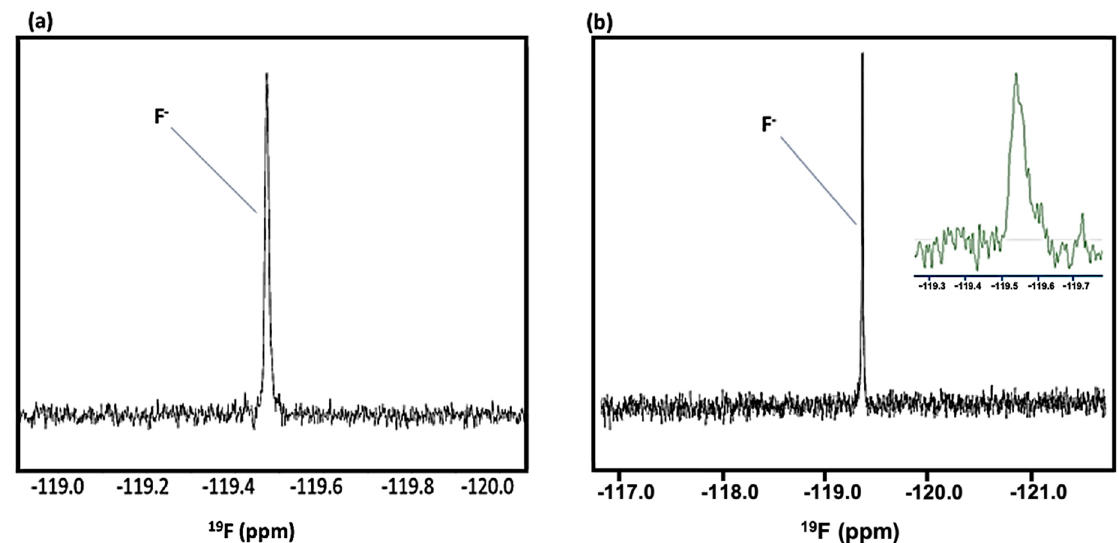
Figure 2. Newly Developed Biomedical Applications of High-Field 19 F NMR Spectroscopy: Analysis of Human Saliva and Tap Water. 19 F NMR spectra of ( a ) an aqueous sodium fluoride calibration standard ( δ F = − 119.5 ppm; final analyte concentration 17.6 µ mol./L) and ( b ) a WMSS sample collected from a participant following an 8.00 h. oral abstention ‘fasting’ period. Analysis solutions contained 527 µ L of a 20 µ mol./L sodium fluoride solution, 60 µ L of 2 H 2 O and 13 µ L of a 50.00 mmol./L trifluoroacetate (TFA) internal standard ( δ F = − 75.3 ppm). 19 F NMR spectra were acquired on a JNM-ECZ600R/S1 600 MHz NMR spectrometer (operating at a frequency of 564.72 MHz for 19 F), over a 400 ppm spectral width and with an FID acquisition time of 0.92 s. An 8.3 µ s 90 ◦ pulse was used; the relaxation delay between pulses was 3 s. In total, 2048 scans were acquired with 256 K data points, which were then Fourier-transformed with zero-filling to 512 K data points and a single exponential function of 5.0 Hz. Baseline roll signal from the fast-relaxing fluoropolymer species in the NMR probe-head was removed using backward linear prediction (order = 16, sample data 512 points, reconstructed data 32 points); baseline correction was applied to spectra using a polynomial function. The resulting signal-to-noise (STN) ratio for the 19 F resonance in ( a ) was 50:1. Chemical shift values were referenced to external fluorotrichloromethane (CFCl 3 ; Jeol UK Ltd. default reference setting). Inset: Partial 19 F NMR spectrum of a local, East Midlands, UK, sample of tap water (shown in green) demonstrating the detection of fluoride anion therein; this spectrum was also acquired with backward linear prediction and 2048